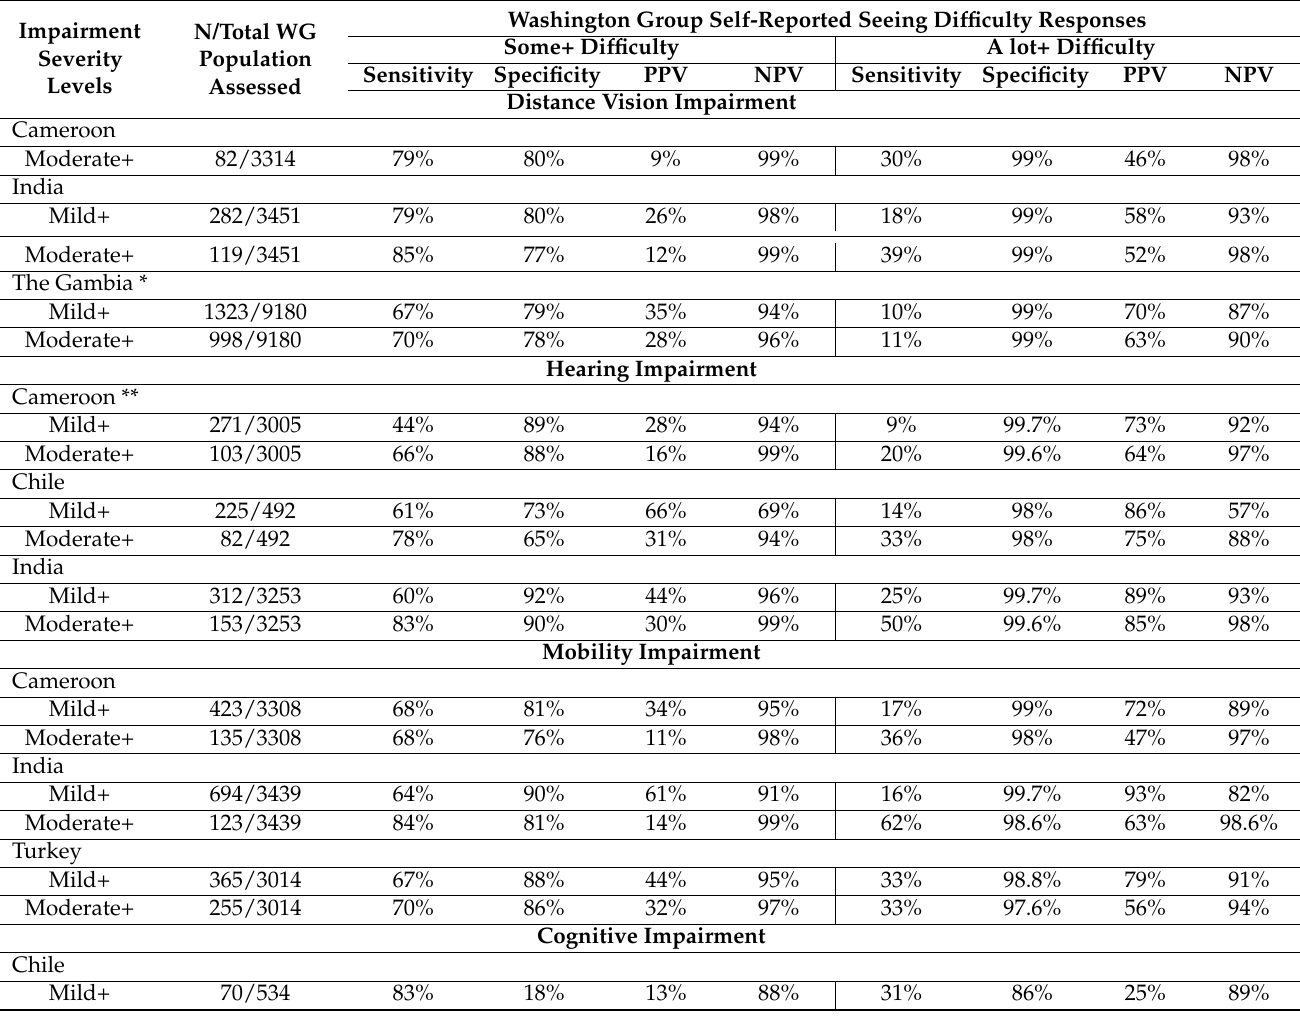
Table 2. Relationship between self-reported difficulties and clinically assessed impairments by functional domain for vision, hearing, mobility and